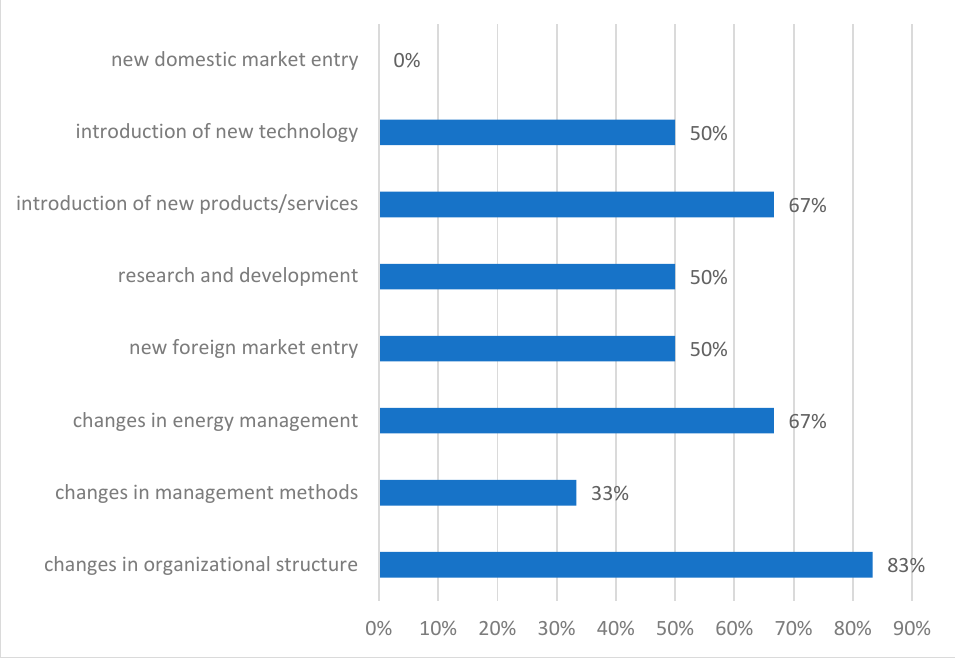
Figure 1. Surveyed entities’ strategic decisions in the past 3 years. Source: own elaboration.